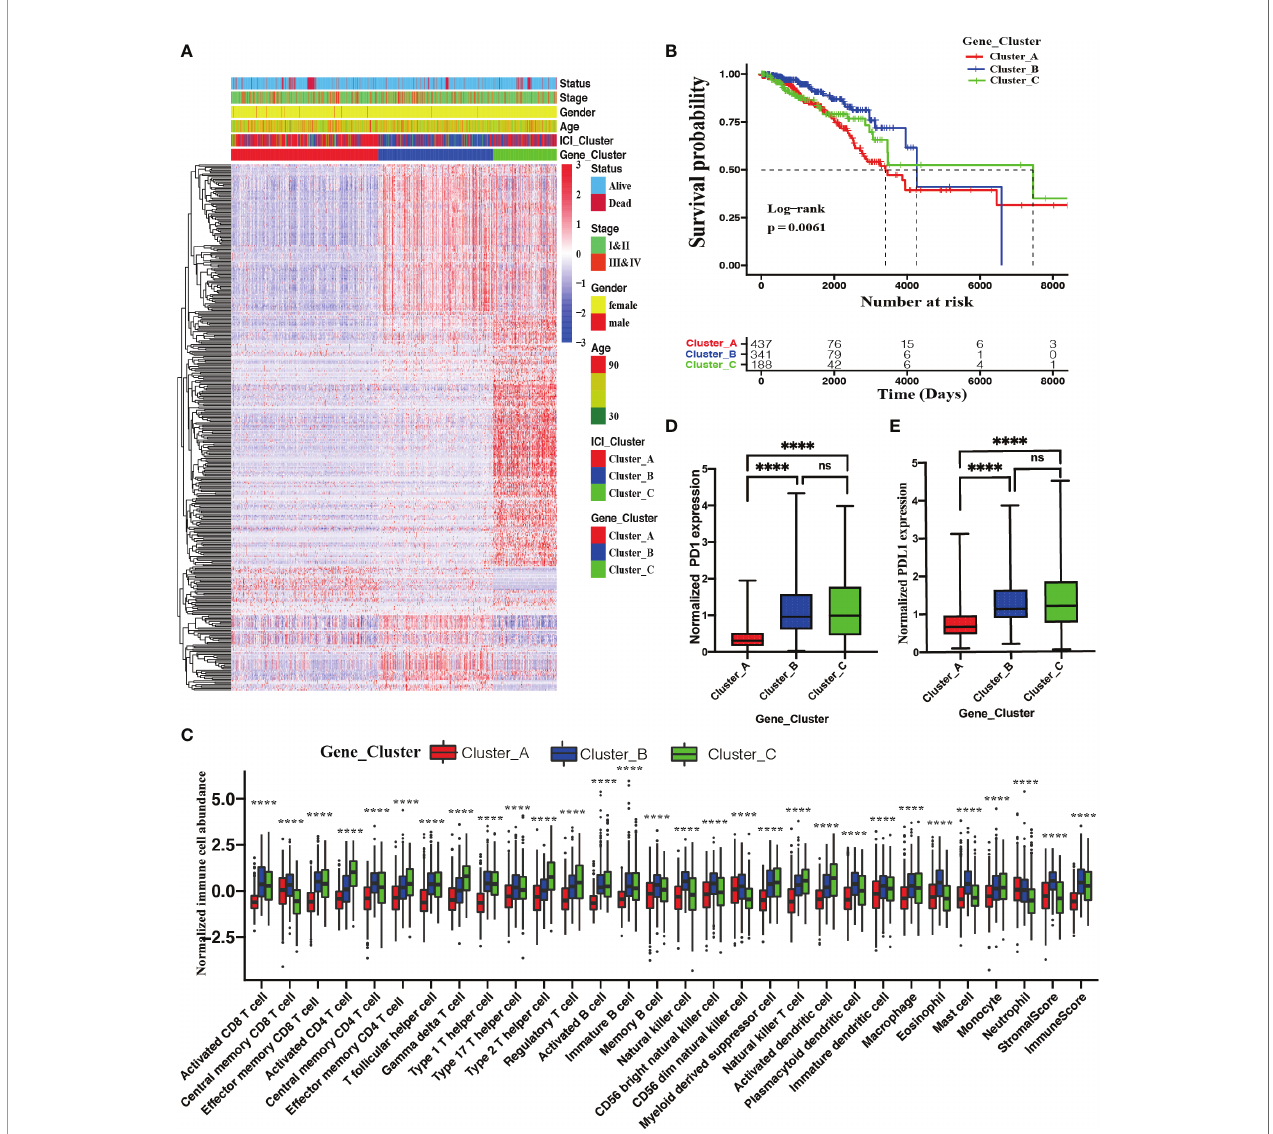
FIGURE 3 | Identi fi cation of ICI genotypes. (A) Unsupervised clustering for DEGs among these distinct ICI clusters, which grouped BRCA patients into three Gene Clusters (A – C) . (B) The Kaplan – Meier curves showing OS outcomes in BRCA patients among these distinct gene clusters. Log-rank test showing P = 0.0061. (C) Normalized immune cell abundances and stromal cell contents in distinct gene clusters. (Kruskal – Wallis test, **** P < 0.0001). Comparison of the expression levels of two vital immune checkpoints (D) and PD-L1 (E) among these distinct ICI clusters; (Wilcoxon test, ns, no signi fi cance P > 0.05; **** P <